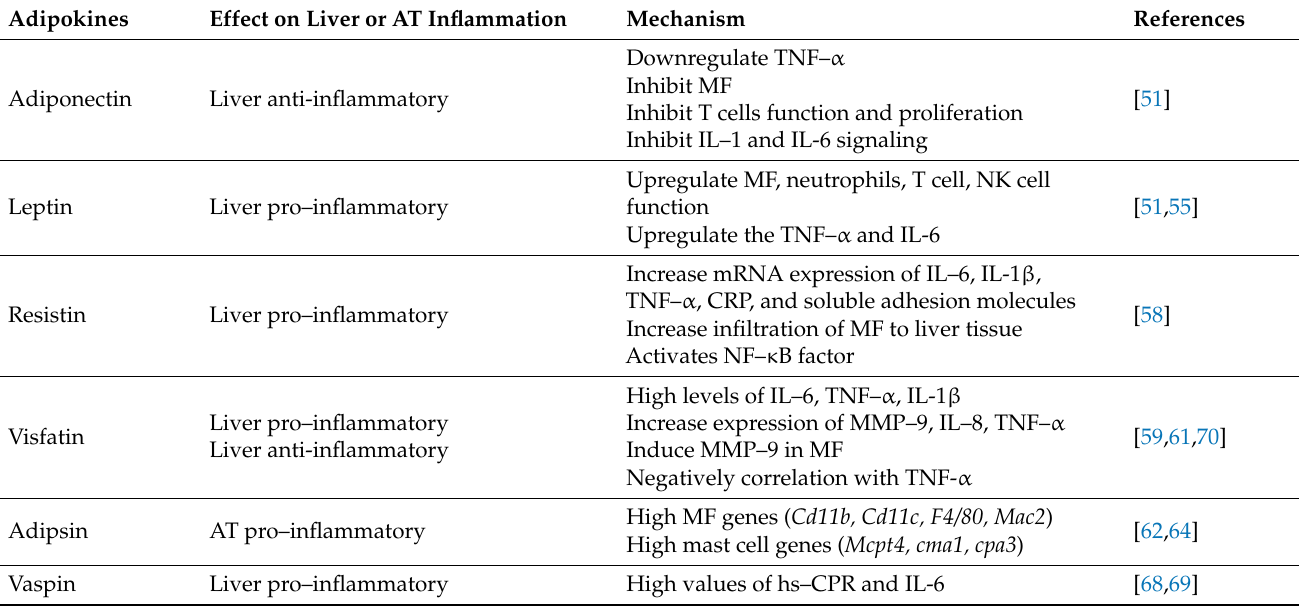
Table 2. The relationship between adipokines and liver or adipose tissue